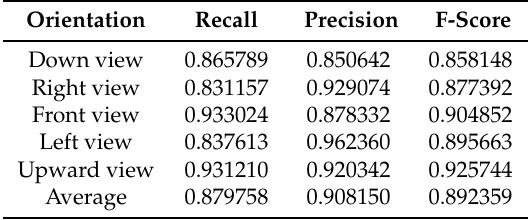
Table 2. Semantic orientation estimation using the Make3D and KITTI datasets. To provide quantitative results, we use three measures ( Recall , Precision and F-score ).